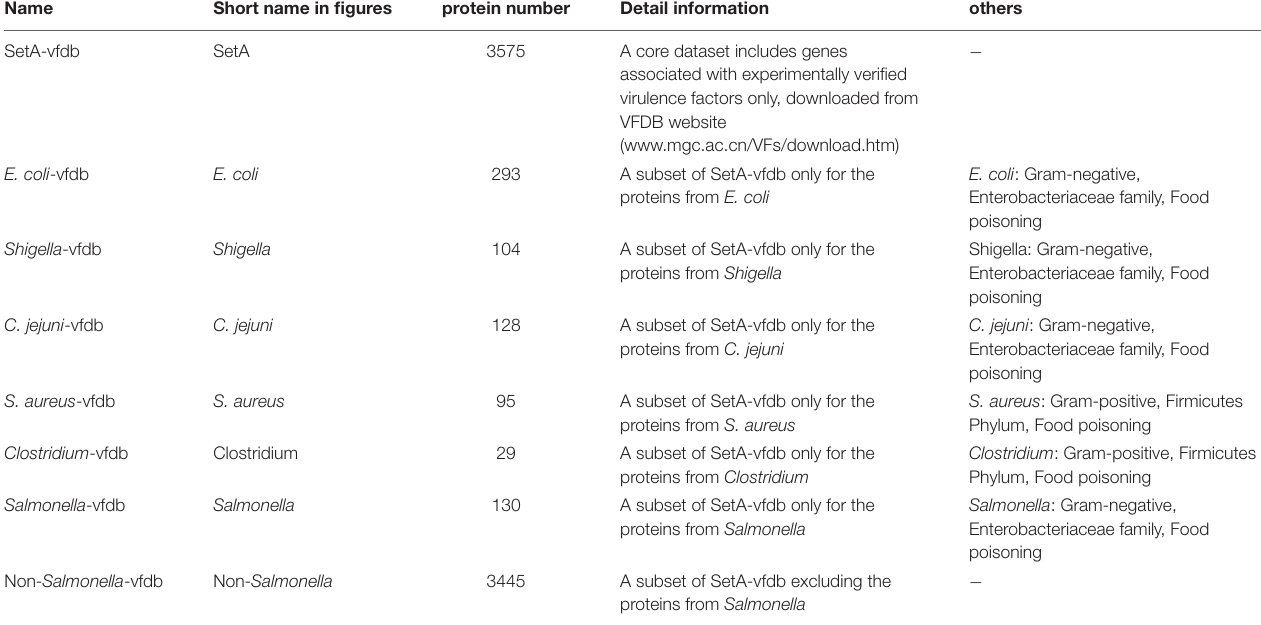
TABLE 2 | Overview of Reference_proteins applied in this